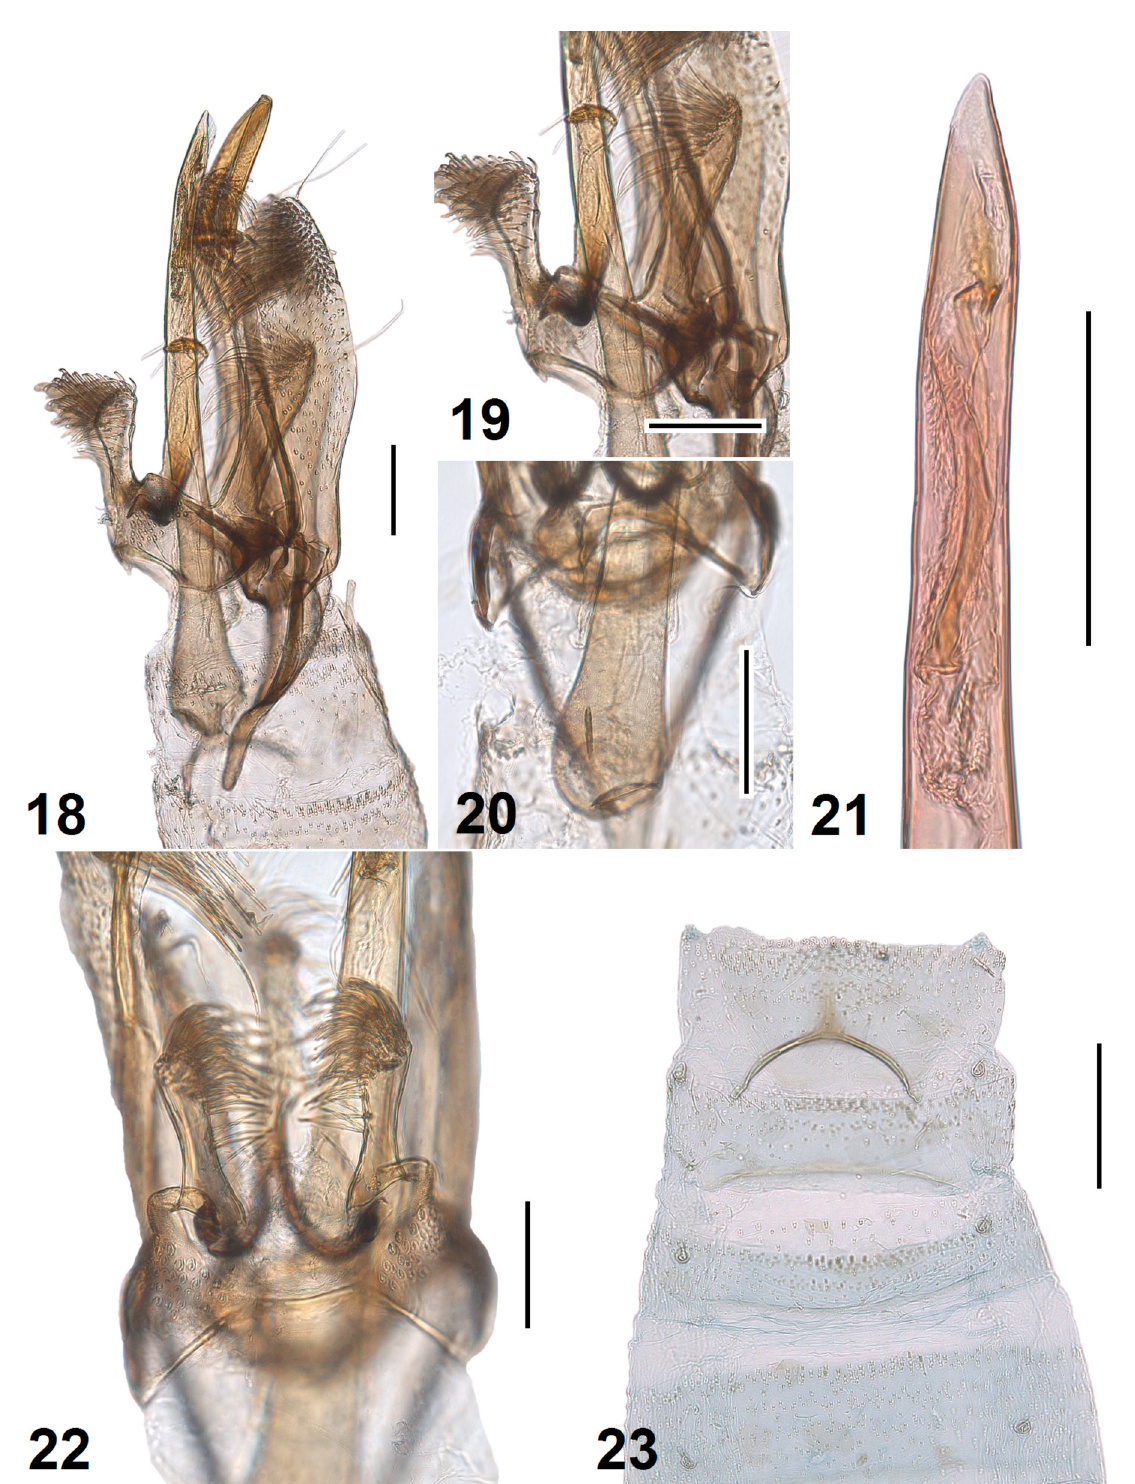
Figs 18–23. Elachista oryx Sruoga & Kaila sp. nov., genitalia, holotype, ♂ (MZH VS1/23.11.18, in glycerol before permanent mounting in Euparal). 18 . Lateral view. 19 . Juxta, lateral view. 20 . Proximal part of phallus. 21 . Distal part of phallus. 22 . Uncus lobes, dorsal view. 23 . Distal part of abdomen, dorsal view. Scale bars = 0.1